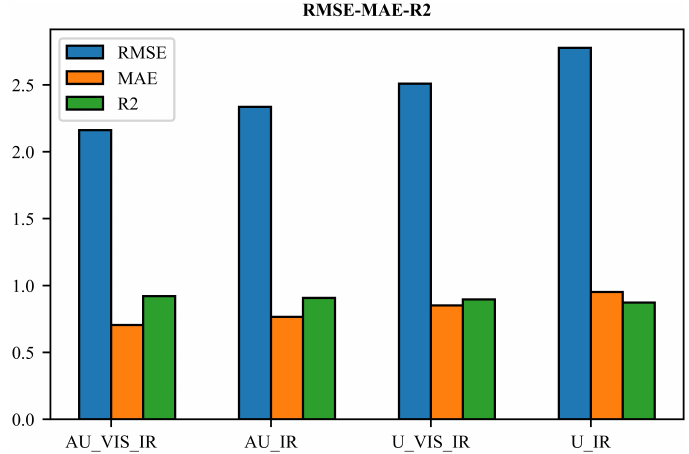
Figure 7. Regression metrics of the 4 models on the test dataset.